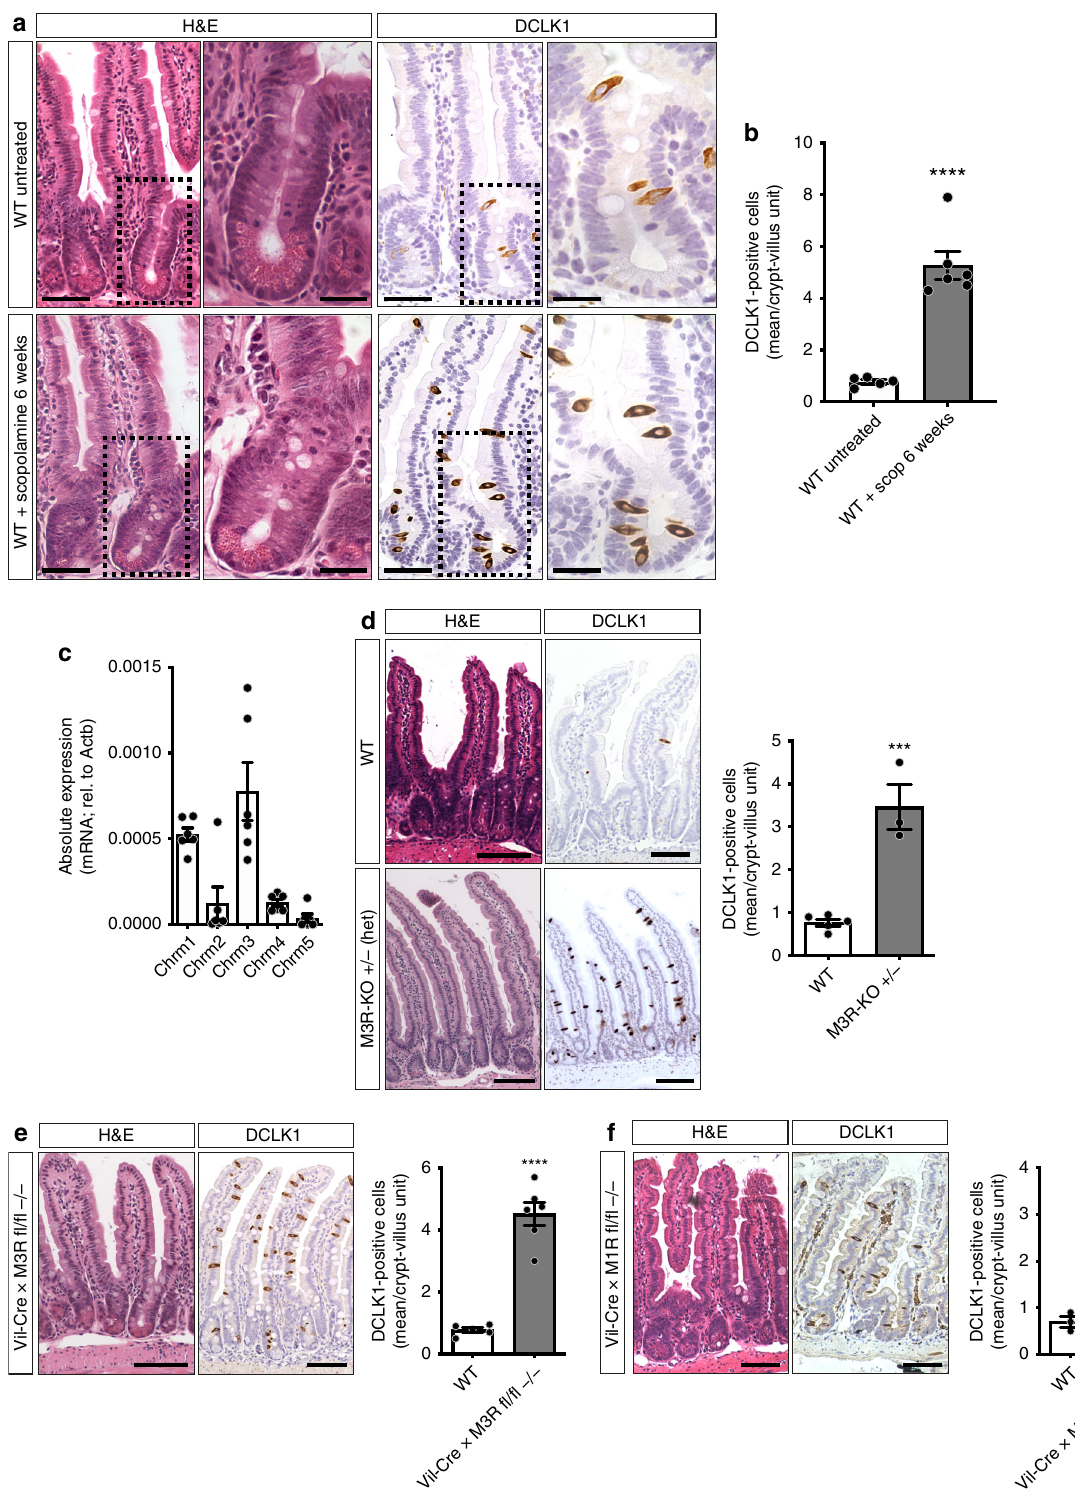
compartments (Supplementary Fig. 3A). In this dataset, the stem compartment was primarily de fi ned by expression of stem cell markers, such as Lgr5 , Ascl2 , Axin2 or Olfm4 , whereas the endocrine cell compartment was de fi ned by expression of markers, such as ChgA , Tac1 , Neurog3 or Prox1 . Only negligible expression of Chrm3 was detected in tuft cells. Thus, while